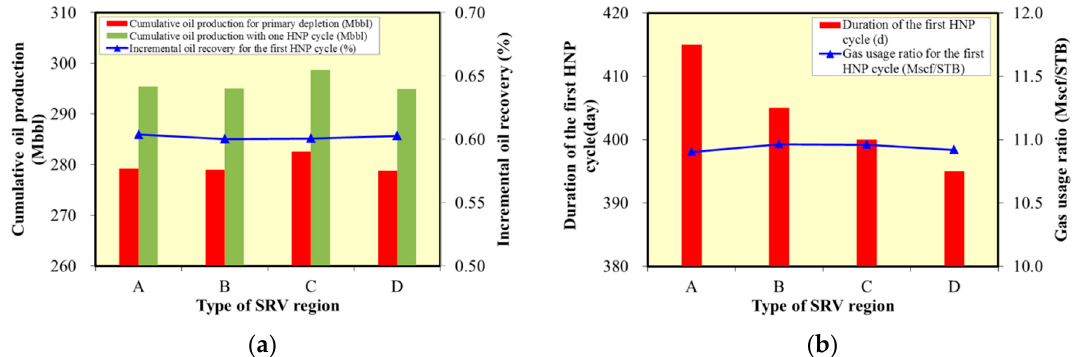
Figure 23. The correlation between types of SRV region and huff-n-puff results: ( a ) Cumulative oil production and incremental oil recovery for different types of SRV region; ( b ) Duration of the first huff-n-puff cycle and gas usage ratio for different types of SRV region. Table 16. Summary of results for huff-n-puff with different permeability magnifications in the SRV region.